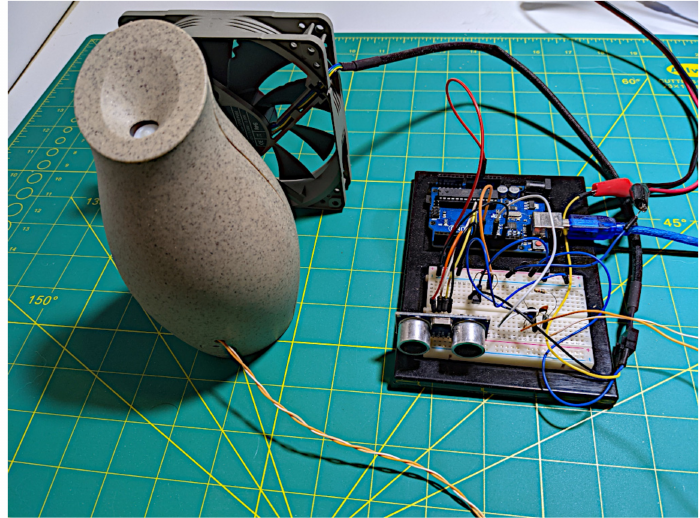
Figure 1. An example of a simple olfactory display (Garcia-Ruiz et al., 2021)